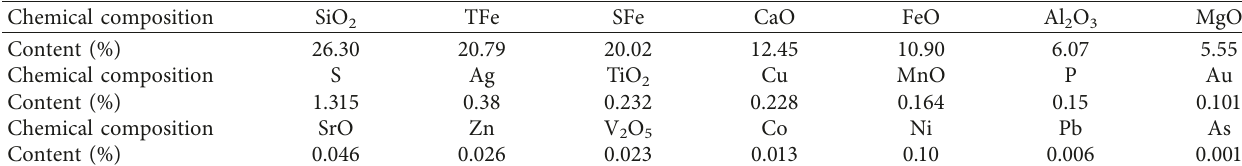
Figure 1: Schematic diagram of the experiment system. (a) Initial stress. (b) Single goaf. (c) Goaf backfill. Table 1: Chemical composition of the tested tailings